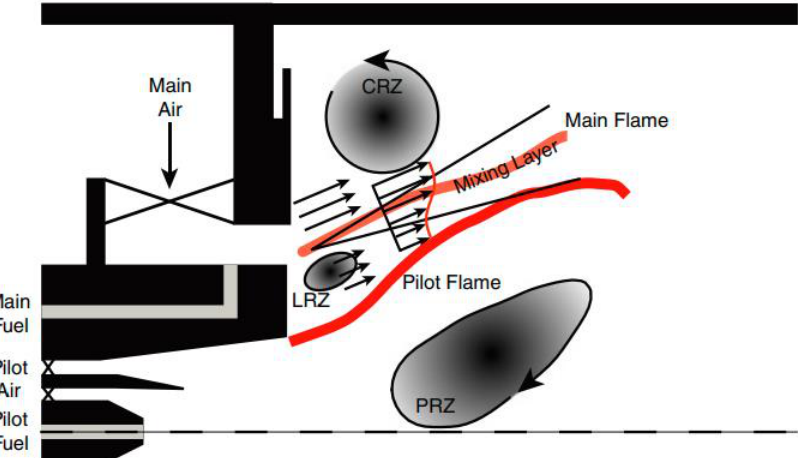
Figure 2. Schematic of a lean, premixed, prevaporized combustor employing a radial swirler [2].